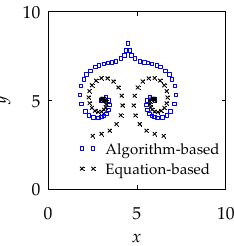
Figure 11. Point-clouds of Ski-uren-moreu created using both the algorithmic approach and